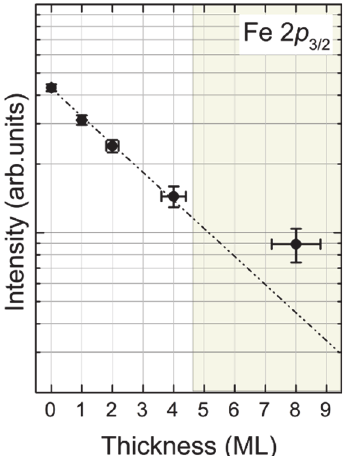
Fig. 4. Intensity of photoemission from the Fe 2 p 3/2 orbital as a function of the CoTPP layer thickness, plotted with a semi- logarithmic scale. The straight line describes the thickness evolution of the first four data points. A deviation from this linear trend is detected at larger coverages (grey